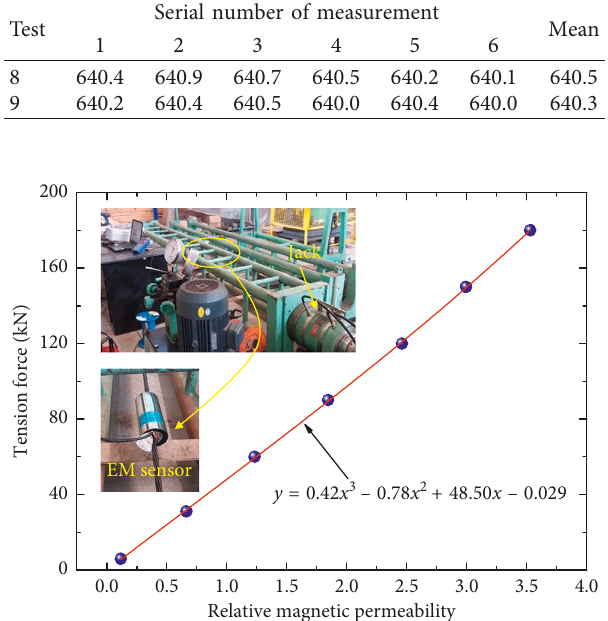
Figure 6: Relative magnetic permeability vs. tension force relationship.